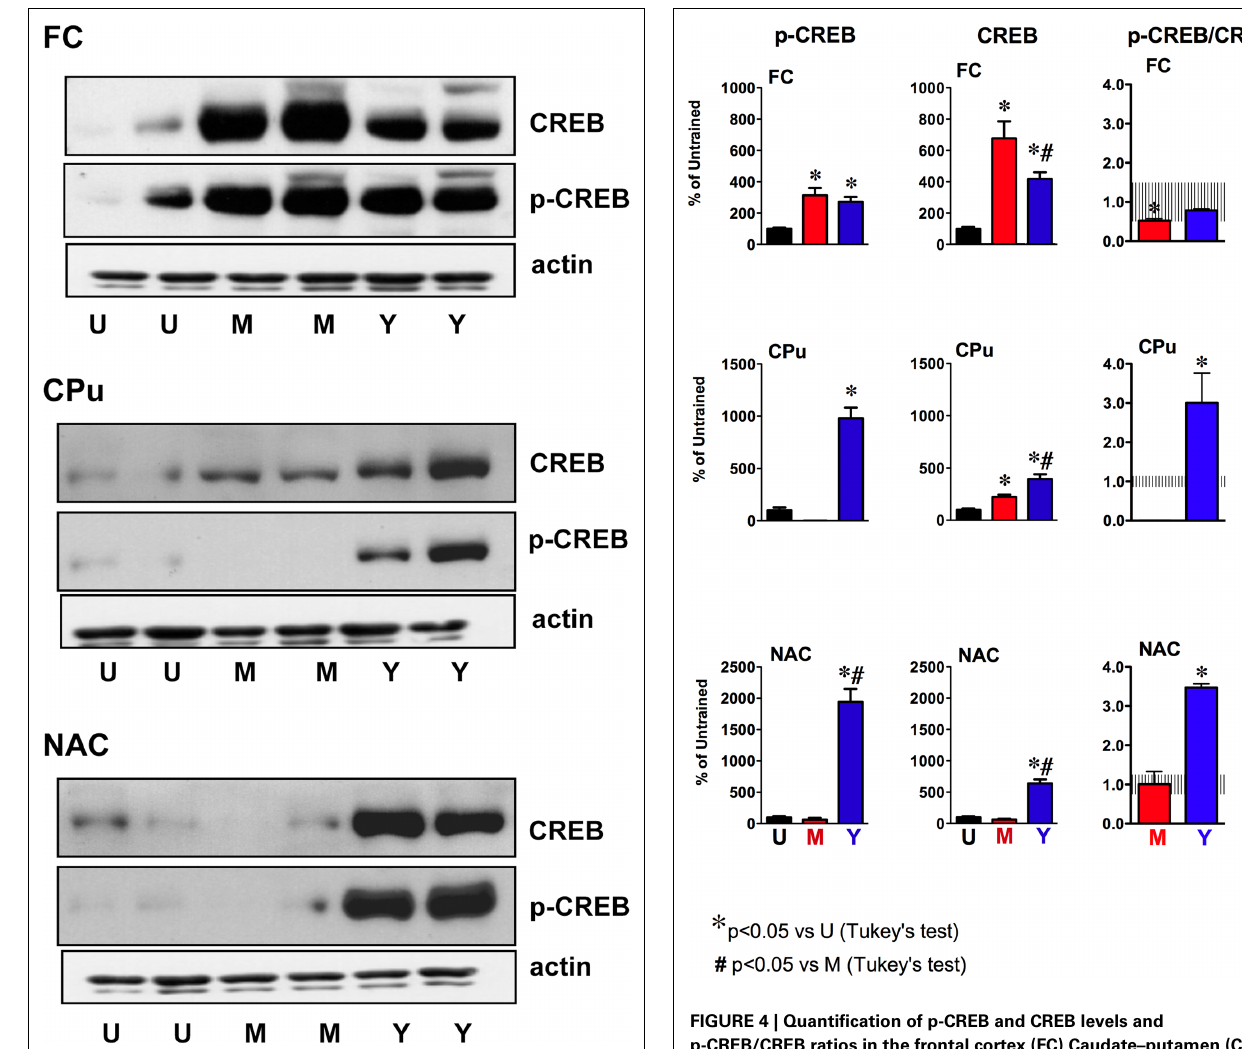
(700%; P < 0.05 vs. master; Tukey’s test) whereas in the CPu the increase in CREB signal was larger in yoked compared to master rats ( P < 0.05; Tukey’s test). In all brain regions examined, actin levels ( Figure 3 ) did not change across experimental